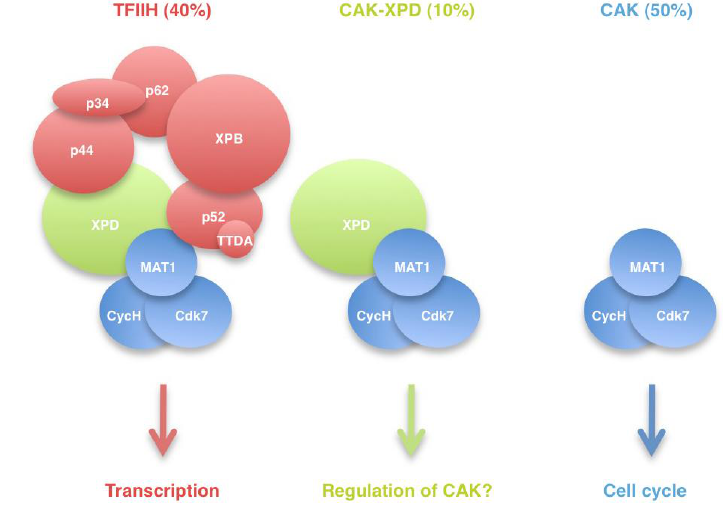
FIGURE 2. The three Cdk7-containing complexes. The Cdk7 kinase can be found in three different complexes, TFIIH, CAK-XPD, and CAK, that represent 40, 10, and 50% of the Cdk7-containing complexes (personal data), respectively. When Cdk7 is in TFIIH, it functions in transcription, while it functions in cell cycle progression when it is in CAK alone or associated with